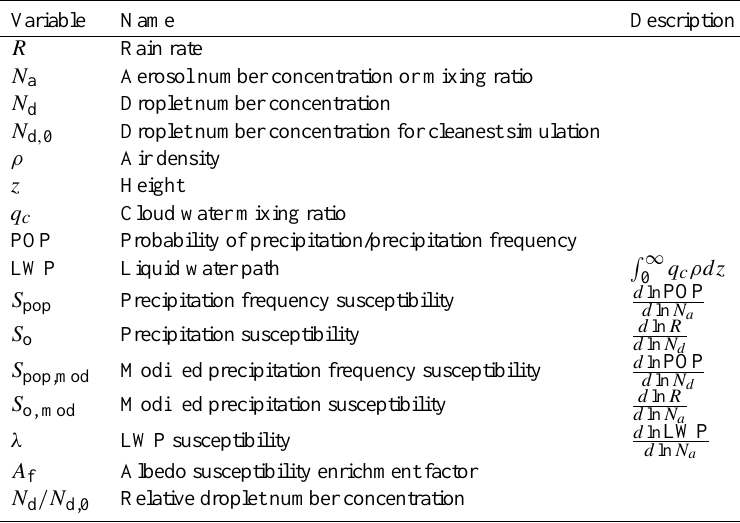
Table 2. Variable names and definitions. Variable Name